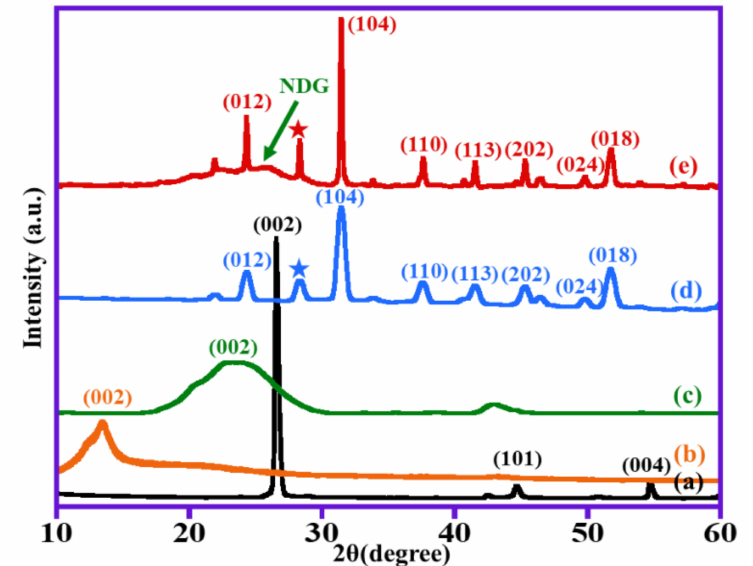
Figure 1. XRD analysis of ( a ) graphite, ( b ) GO, ( c ) NDG, ( d ) un-doped (1%) ZnO–MnCO 3 catalyst, and ( e ) (1%)ZnO–MnCO 3 /(1%-NDG)